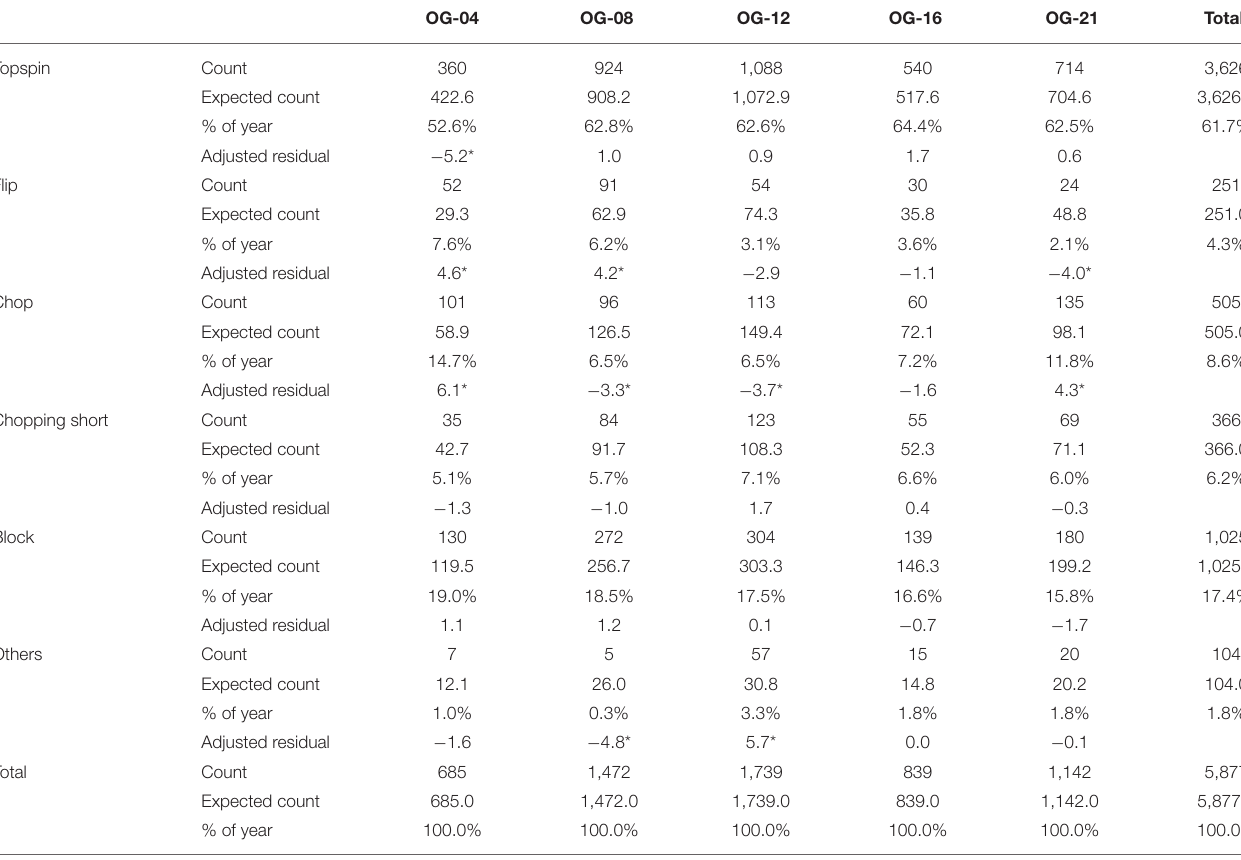
TABLE 2 | The distribution of stroke type throughout the different Olympic Games from 2004 to